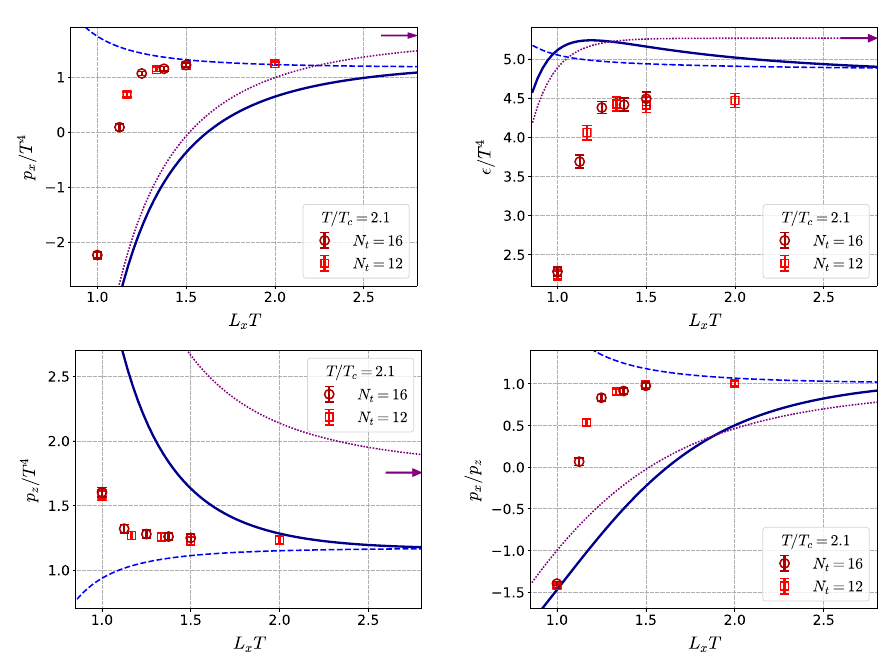
Figure 3. L x T dependence of p x (upper-left panel), p z (lower-left panel) and ϵ (upper-right panel), normalized by T 4 with T = 2 . 1 T ∞ . The lower-right panel represents the ratio p x / p z . The detail is c provided in the main